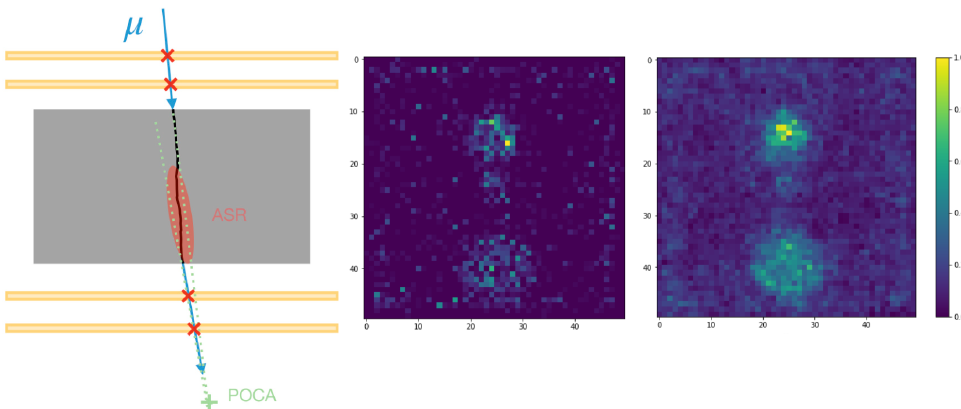
Figure 16. PoCA and ASR path reconstruction comparison for an event where the PoCA point is reconstructed outside of the VOI ( left ). A volume density map using the PoCA algorithm ( middle ) and ASR ( right ) is computed from 100 k muon tracks in a Monte Carlo simulation based on GEANT4. The simulated objects are 10 cm lead, 5 cm uranium and 15 cm iron spheres (top to bottom). The simulated detector consists of three upper and lower planes with a 2 mm simulated spatial